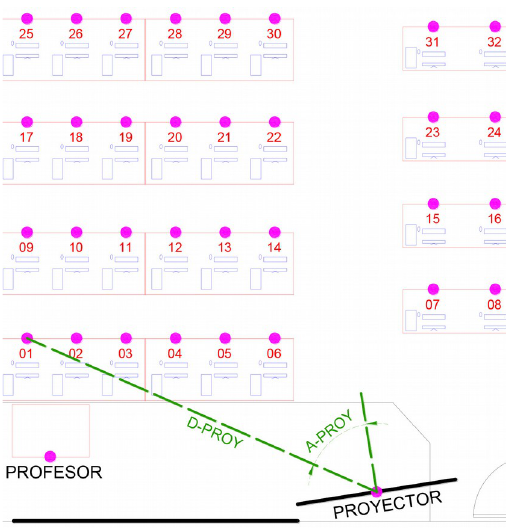
Figure 1. Distribution of positions (computers) in the IT room